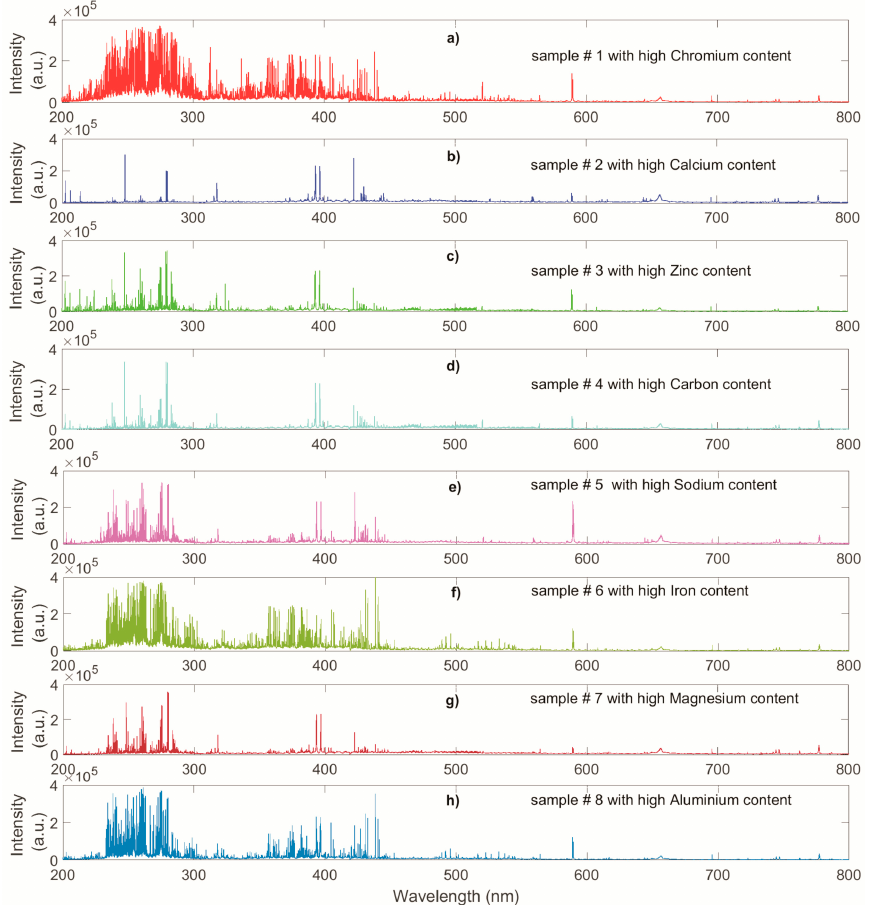
Figure 2. Optical emission spectra of eight different diesel particulate matter (DPM) matrices measured by laser-induced breakdown spectroscopy.